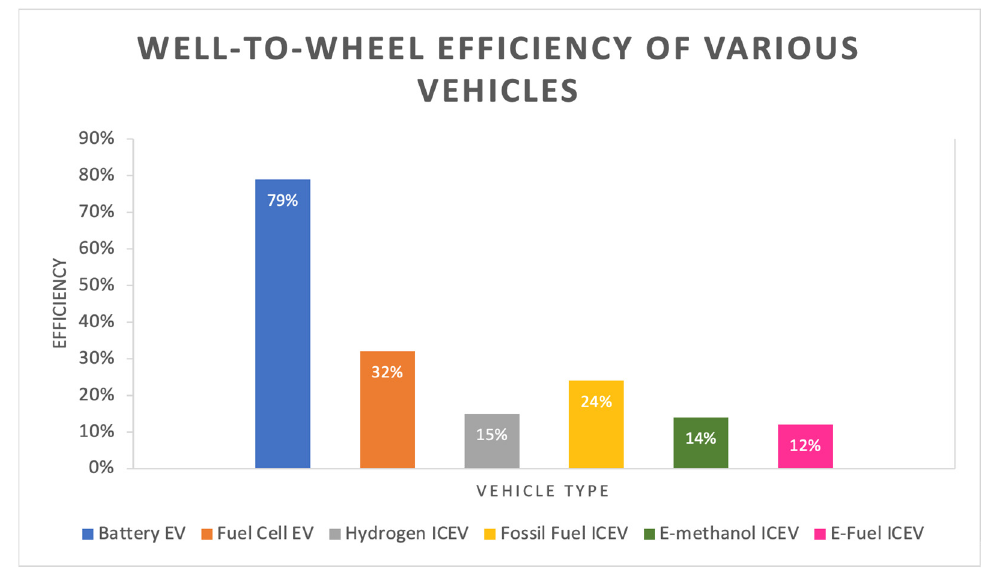
Figure 1. Comparison of well-wheel e ffi ciency between vehicles of various fuels.